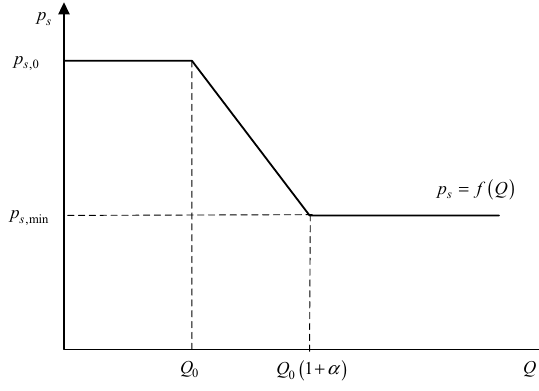
Figure 2. The “incremental electricity price” standard.